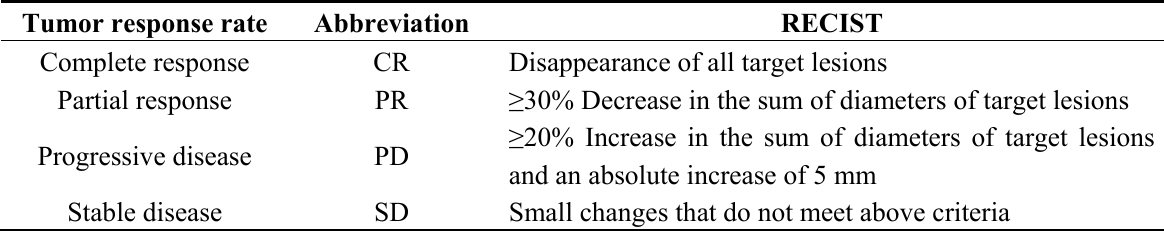
Table 1. Summary of TRR and RECIST criteria as defined by Eisenhauer, Therasse et al. 2009